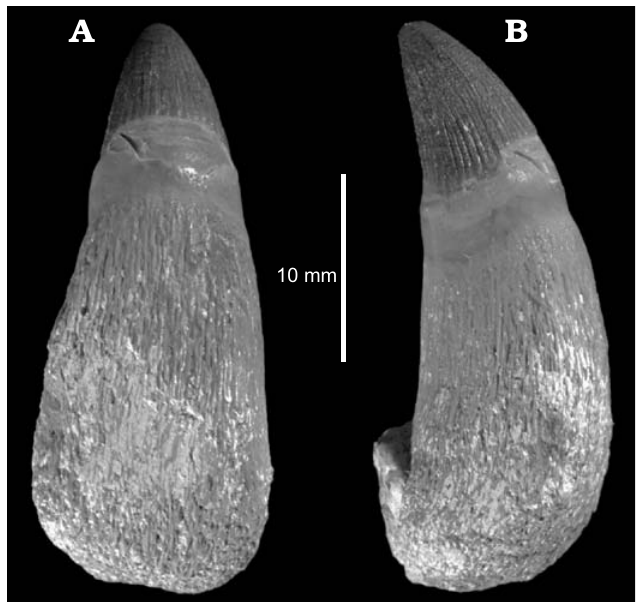
Fig. 4. Ophthalmosaurid ichthyosaur Cryopterygius kielanae sp. nov. (GMUL 3579-81, holotype) from the Late Jurassic of Owadów-Brzezinki Quarry; tooth in labial ( A ) and anterior ( B )